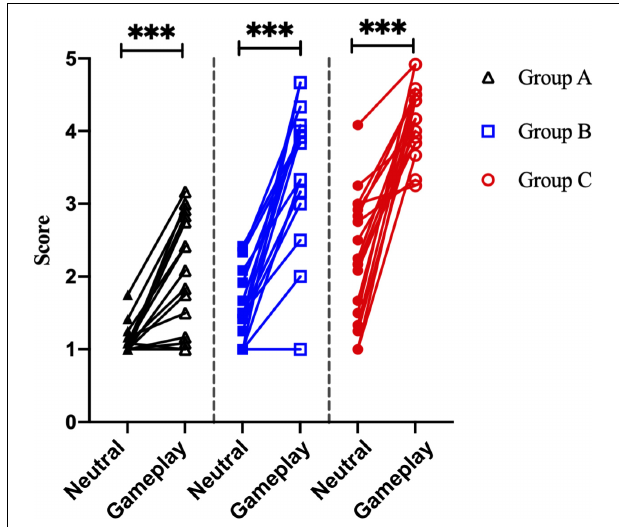
FIGURE 4 | Analysis of the self-reported craving scores of 51 participants. *** p < 0.0001 (paired sample t